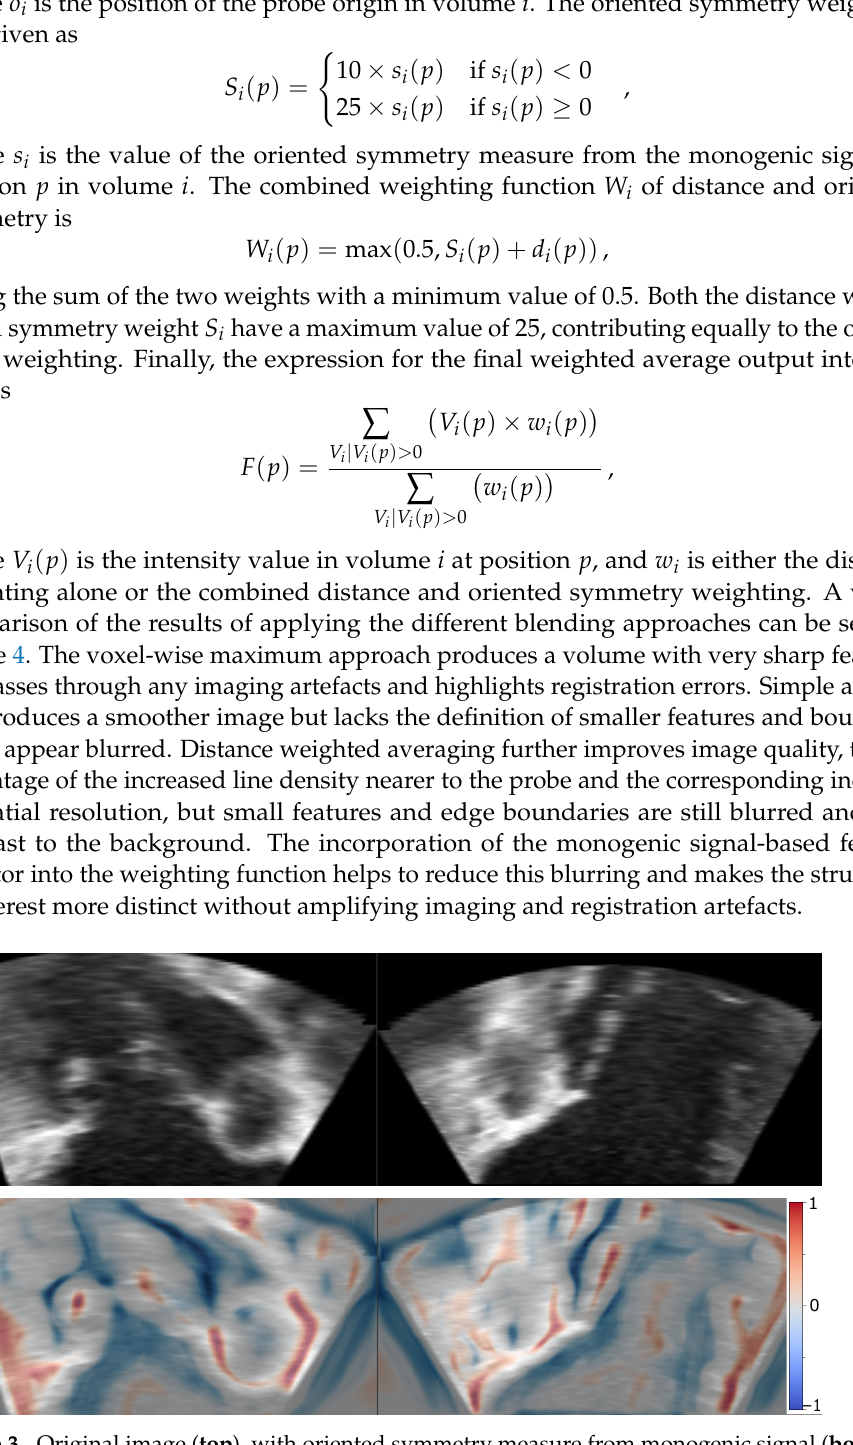
Figure 3. Original image ( top ), with oriented symmetry measure from monogenic signal ( bottom